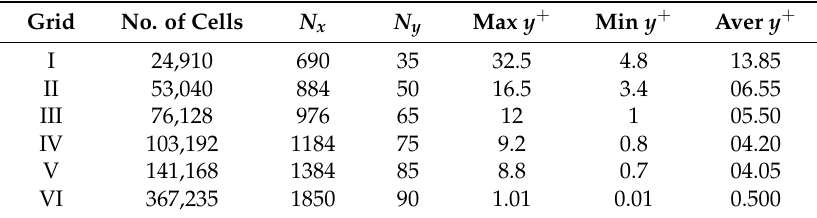
Table 1. Details of grids used in mesh sensitivity